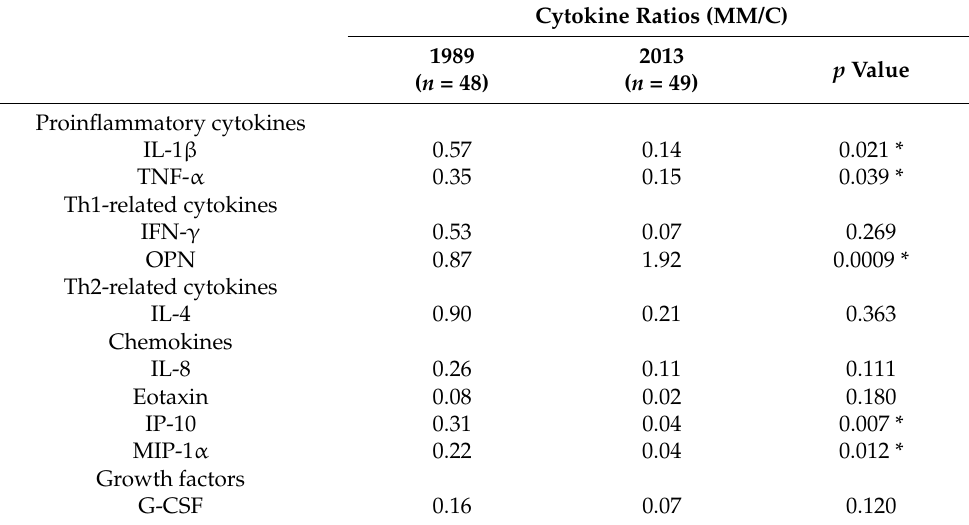
Table 4. Lactational change ratios of cytokines